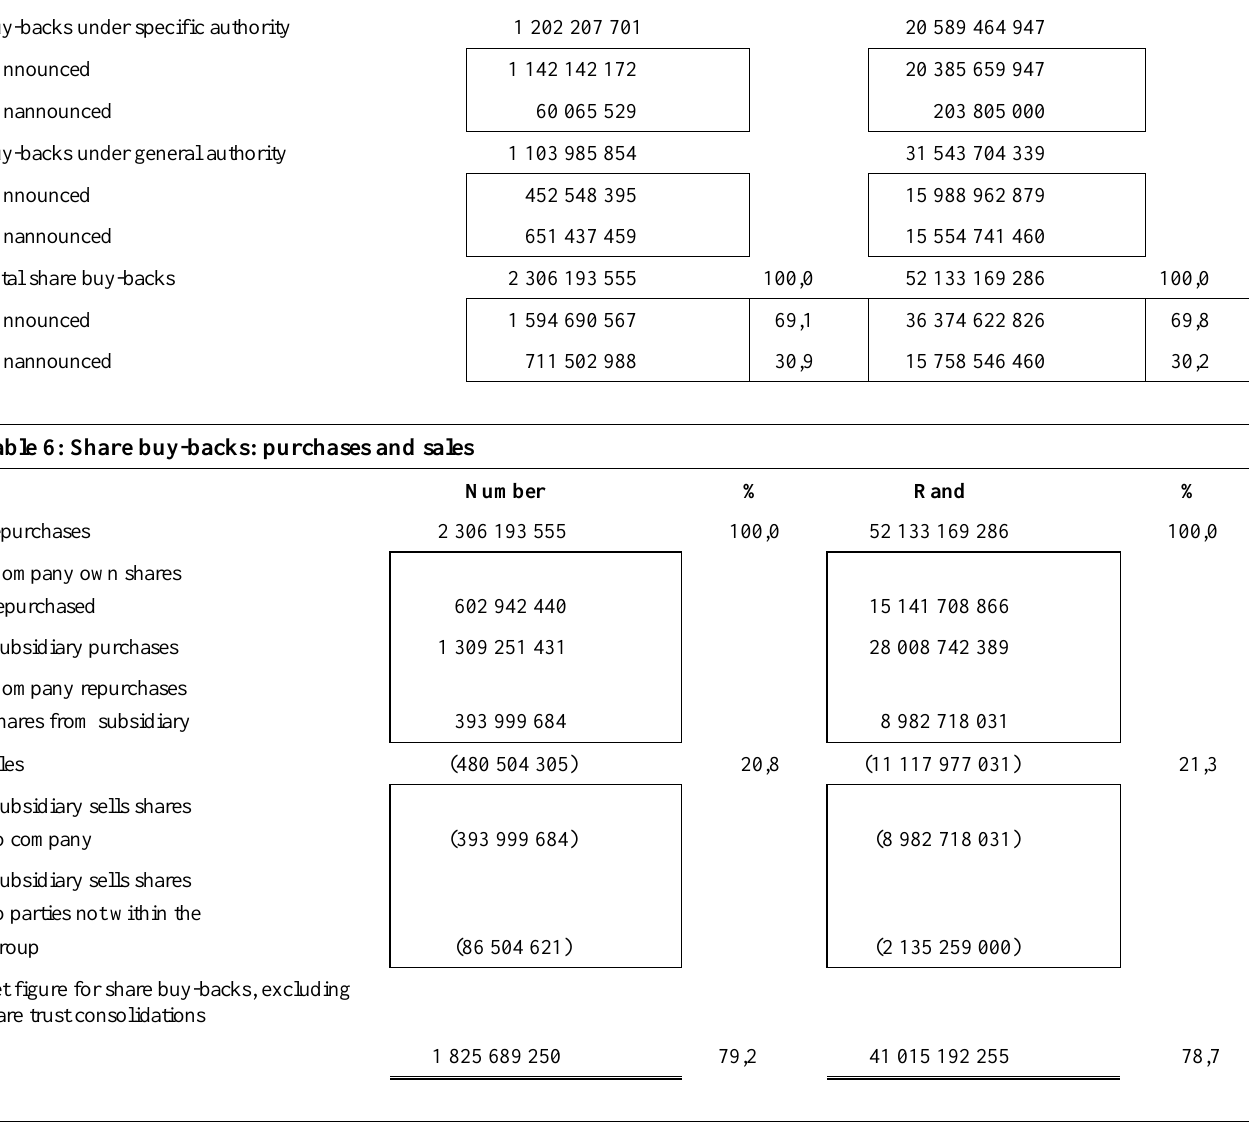
Table 5: Share buy-backs: announced vs. unannounced Buy-backs under specific authority